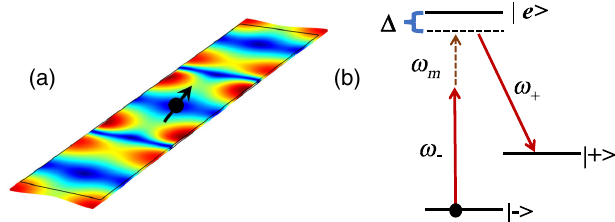
FIG. 2. (a) Displacement pattern of a fifth-order compression mode in a thin rectangular diamond plate with dimension ð 27 ; 8 ; 0 . 3 Þ μ m. (b) Schematic of a spin qubit coupling to a mechanical mode with frequency ω through a resonant Raman m process, driven by two external optical fields with frequency ω þ and ω − . We can couple the spin qubit to a given mechanical mode by choosing a suitable detuning between ω and ω − þ